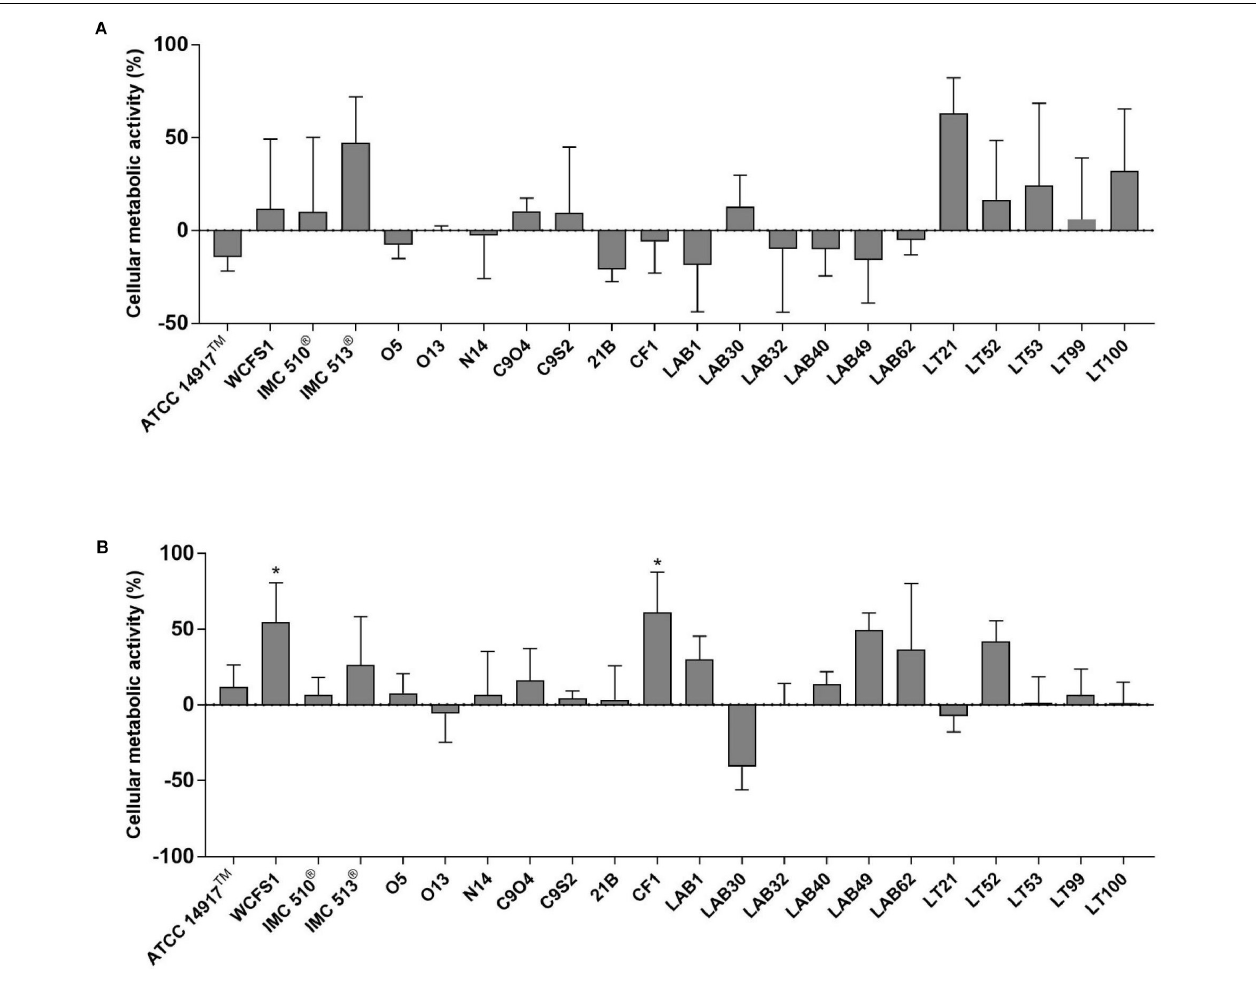
FIGURE 2 | Evaluation of cellular metabolic activity in NCM460 cells incubated with Lactobacillus plantarum strains for 4 h (A) and 24 h (B) . Data are shown as mean ratio (percentage – 100; ± SD) of absorbance in the samples well (OD of human cells with bacteria) and negative control (OD of human cells): (OD S / OD NC × 100) −